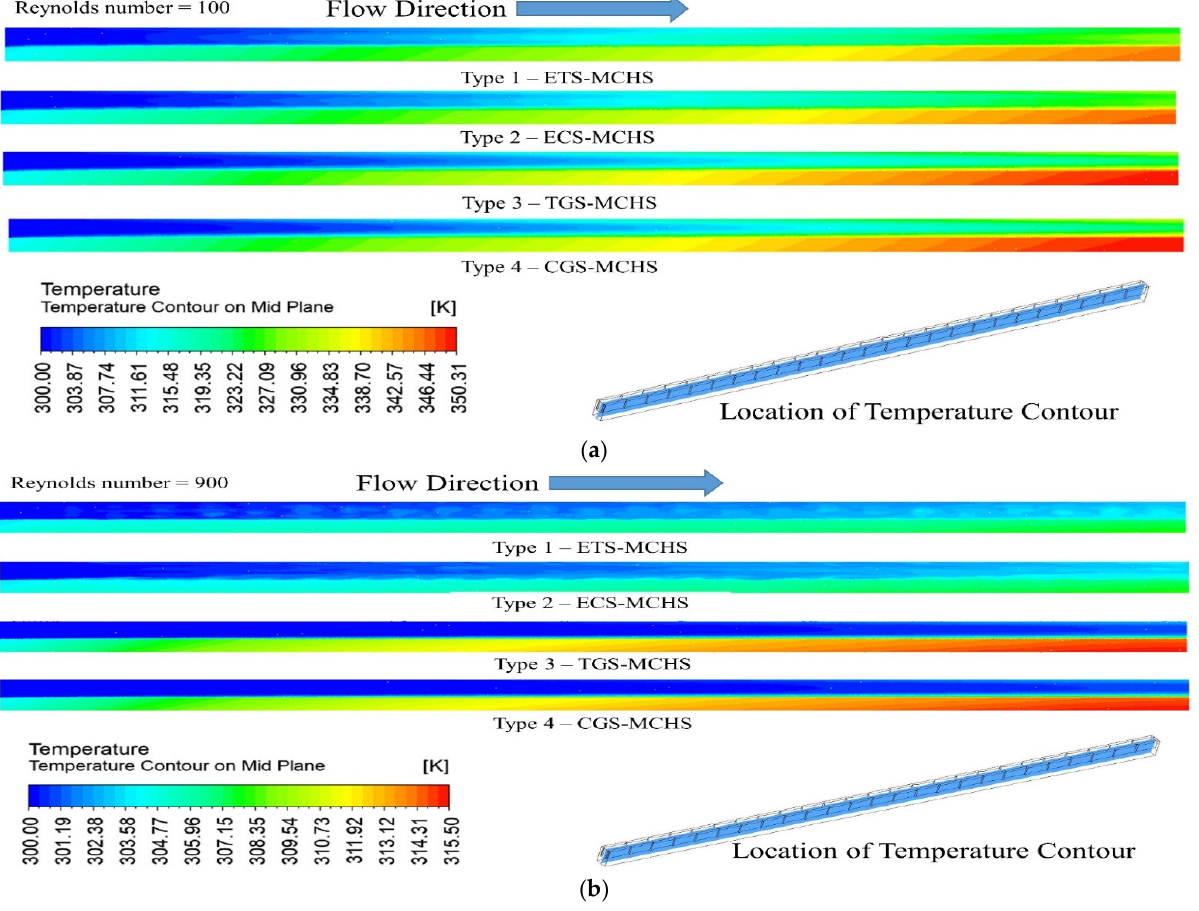
Figure 7. Temperature contour of heat transfer fluid and MCHS (at mid plane) for ( a ) Re = 100 and ( b ) Re = 900.